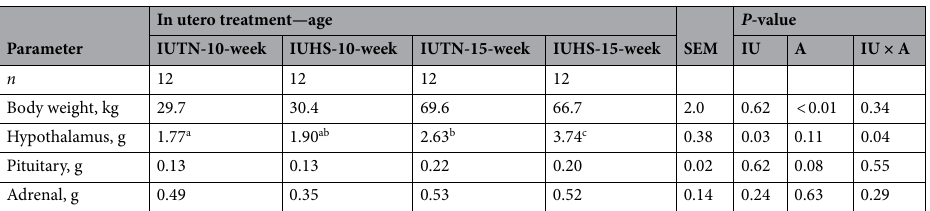
Table 2. Effects of in utero heat stress (IUHS) and age on body weight and hypothalamus, pituitary, and adrenal gland weights in pigs. Letters ( a, b, C ) indicate significant differences ( P ≤ 0.05) within a row. IUTN in utero thermoneutral, IU in utero treatment, A age.